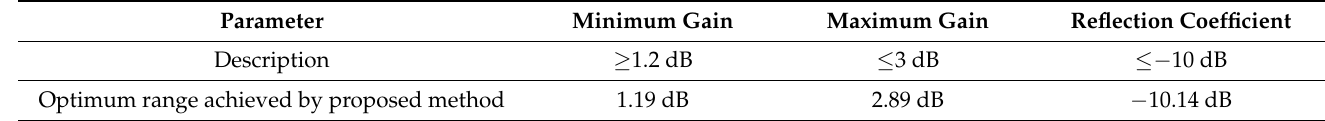
Table 3. Description of the designed model and achieved outcomes by presented model.